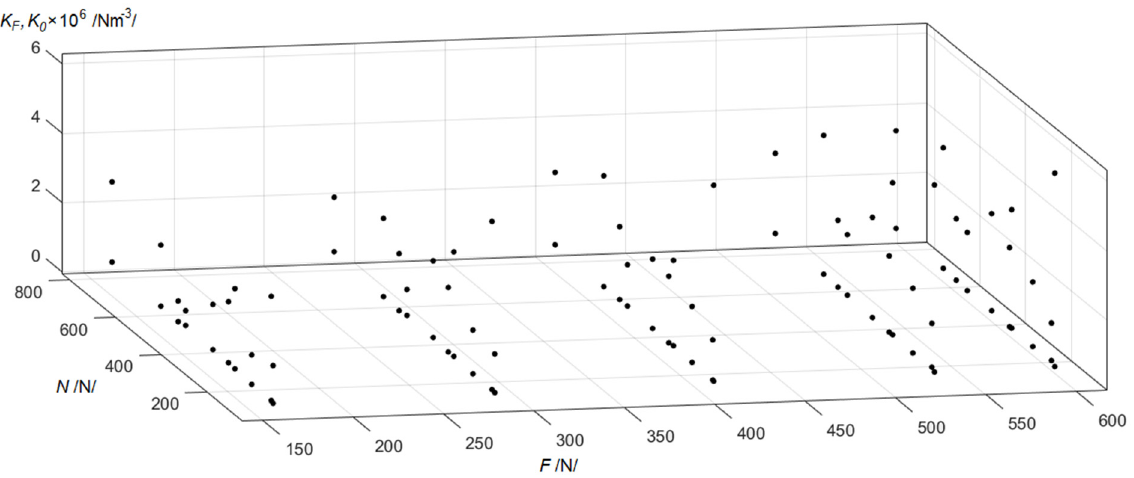
Figure 9. Relationship 𝐾 (cid:3007) ,𝐾 (cid:2868) = function(𝐹,𝑁) /Nm − 3 / for wheat layer thickness h = 36 mm.